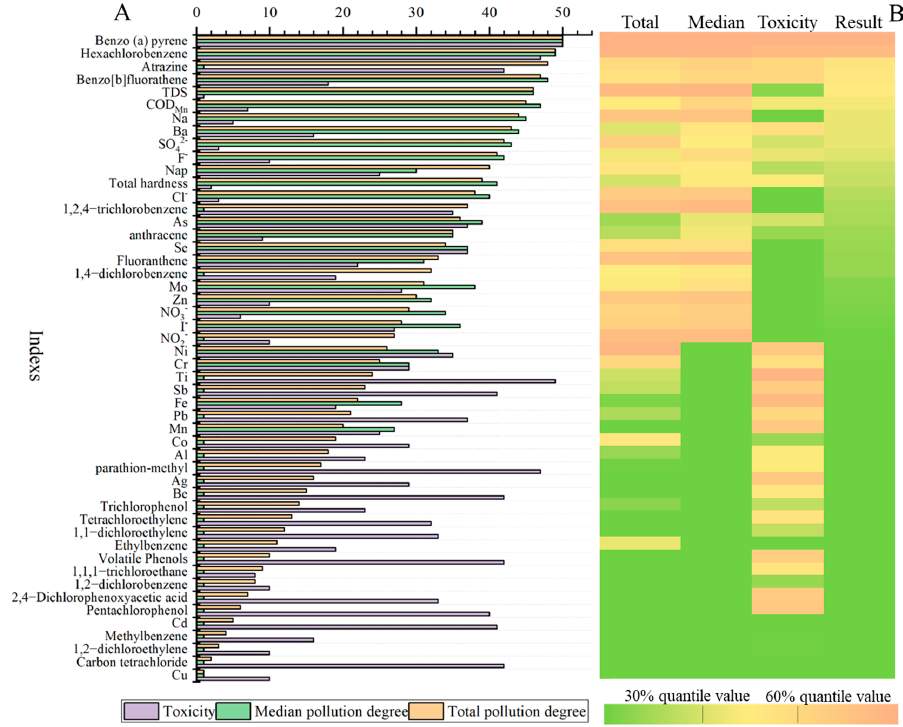
Figure 8. Screening results by the multiplication method. ( A ) Screening results of each indexs; ( B ) The heat map of screening results.